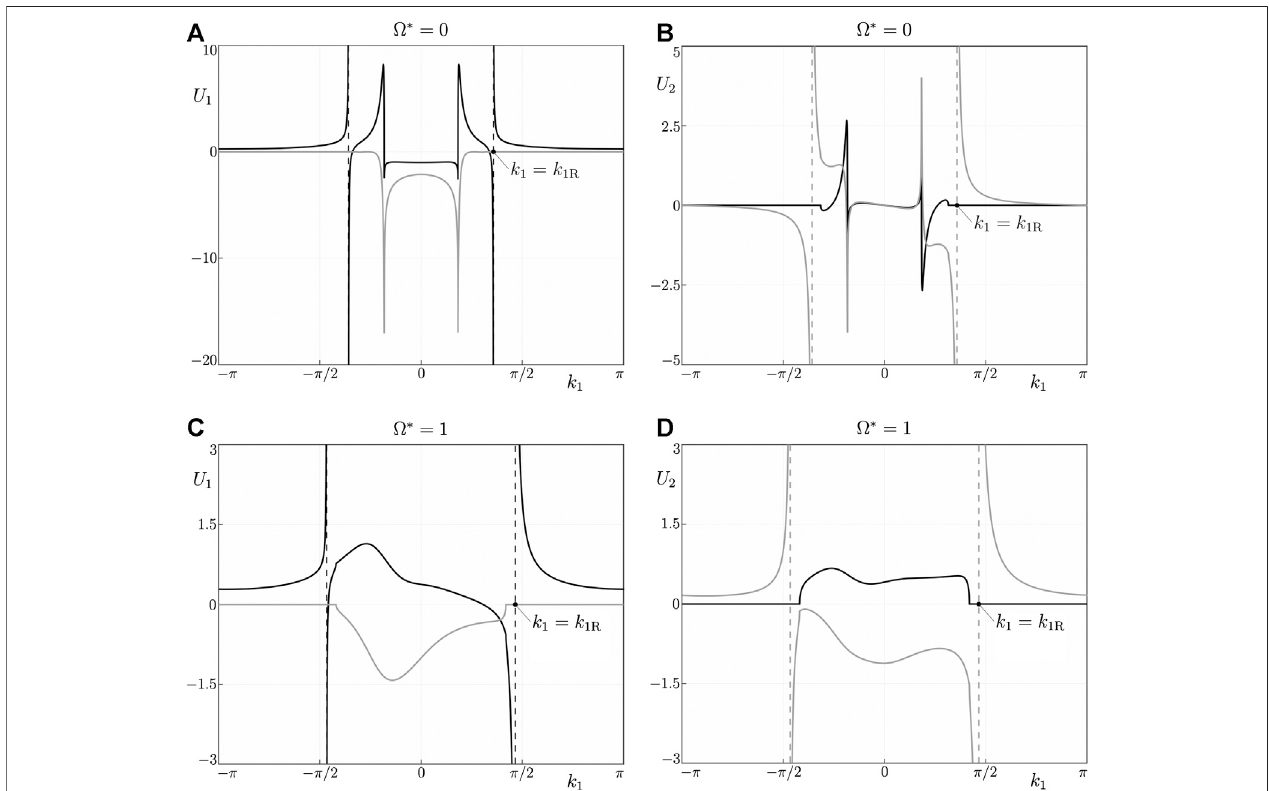
FIGURE2| PlotsofthediscreteFouriertransformofthesteady-statesolutionin Eq.21 ,for n 2 (cid:1) 0.Parts A,C(B,D) showthe fi rst(second)componentof U F 0 for Ω * (cid:1) 0and Ω * (cid:1) 1, respectively. The real parts of the components are represented by black curves, whereas the imaginary parts are indicated by gray curves. The vertical dashed lines represent the wave numbers ± k 1R for which these components are singular, having simple poles. The computations are performed for ω 0 (cid:1) 0 . 8 and P (cid:1) ( 1 , 0 ) T .